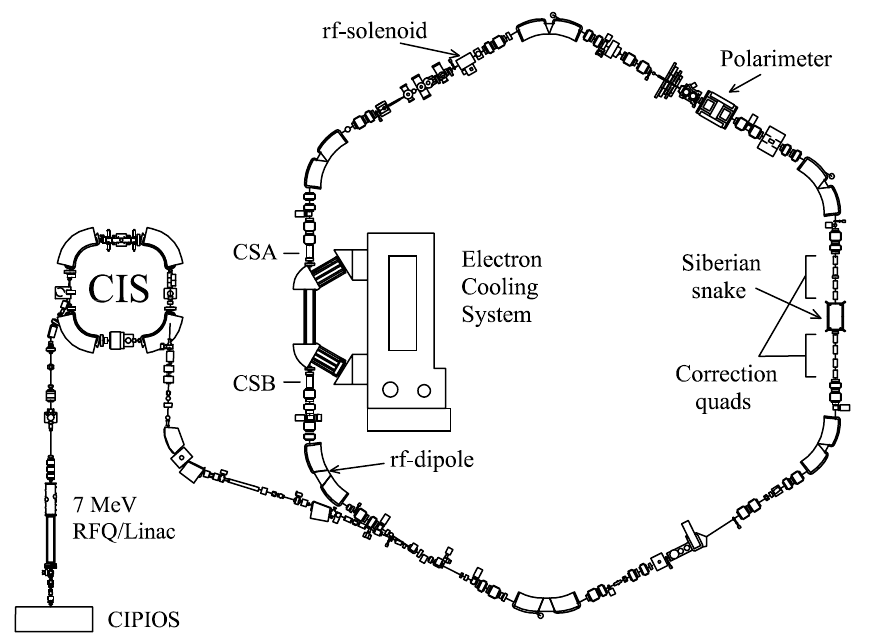
FIG. 1. Layout of the IUCF Cooler Ring with its new CIS injector and CIPIOS polarized ion source. Also shown in the Cooler Ring are the rf dipole, the rf solenoid, the polarimeter, and the Siberian snake.